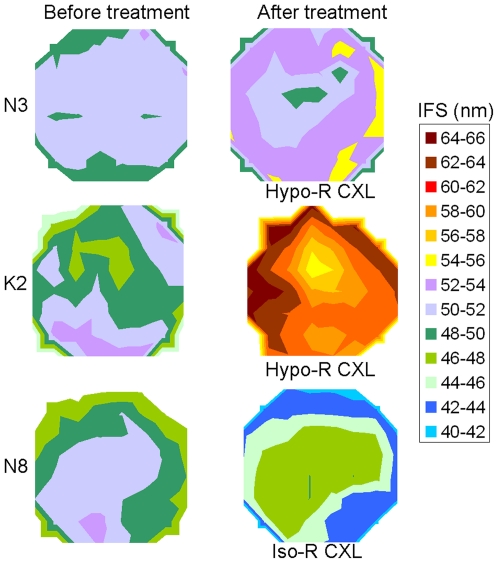
Changes in collagen interfibrillar spacing following Riboflavin/UVA cross-linking.The contour maps show collagen interfibrillar spacing (IFS) in an unswollen normal cornea (N3) and a slightly swollen keratoconus cornea (K2) before and after hypo-osmolar riboflavin/UVA cross-linking (Hypo-R CXL) and a normal unswollen cornea (N8) before and after iso-osmolar riboflavin/UVA cross-linking (Iso-R CXL). The centre of each corneal button corresponds approximately with the centre of each map.